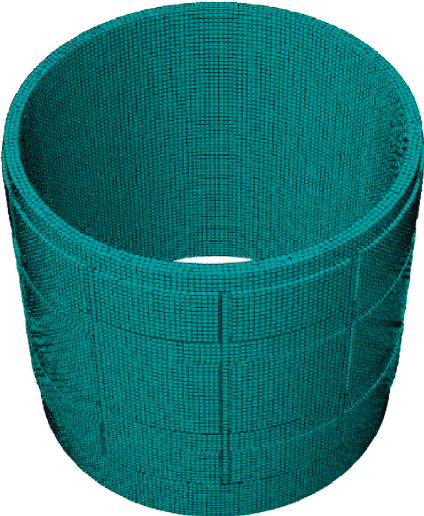
Figure 4: Mandrel meshing.